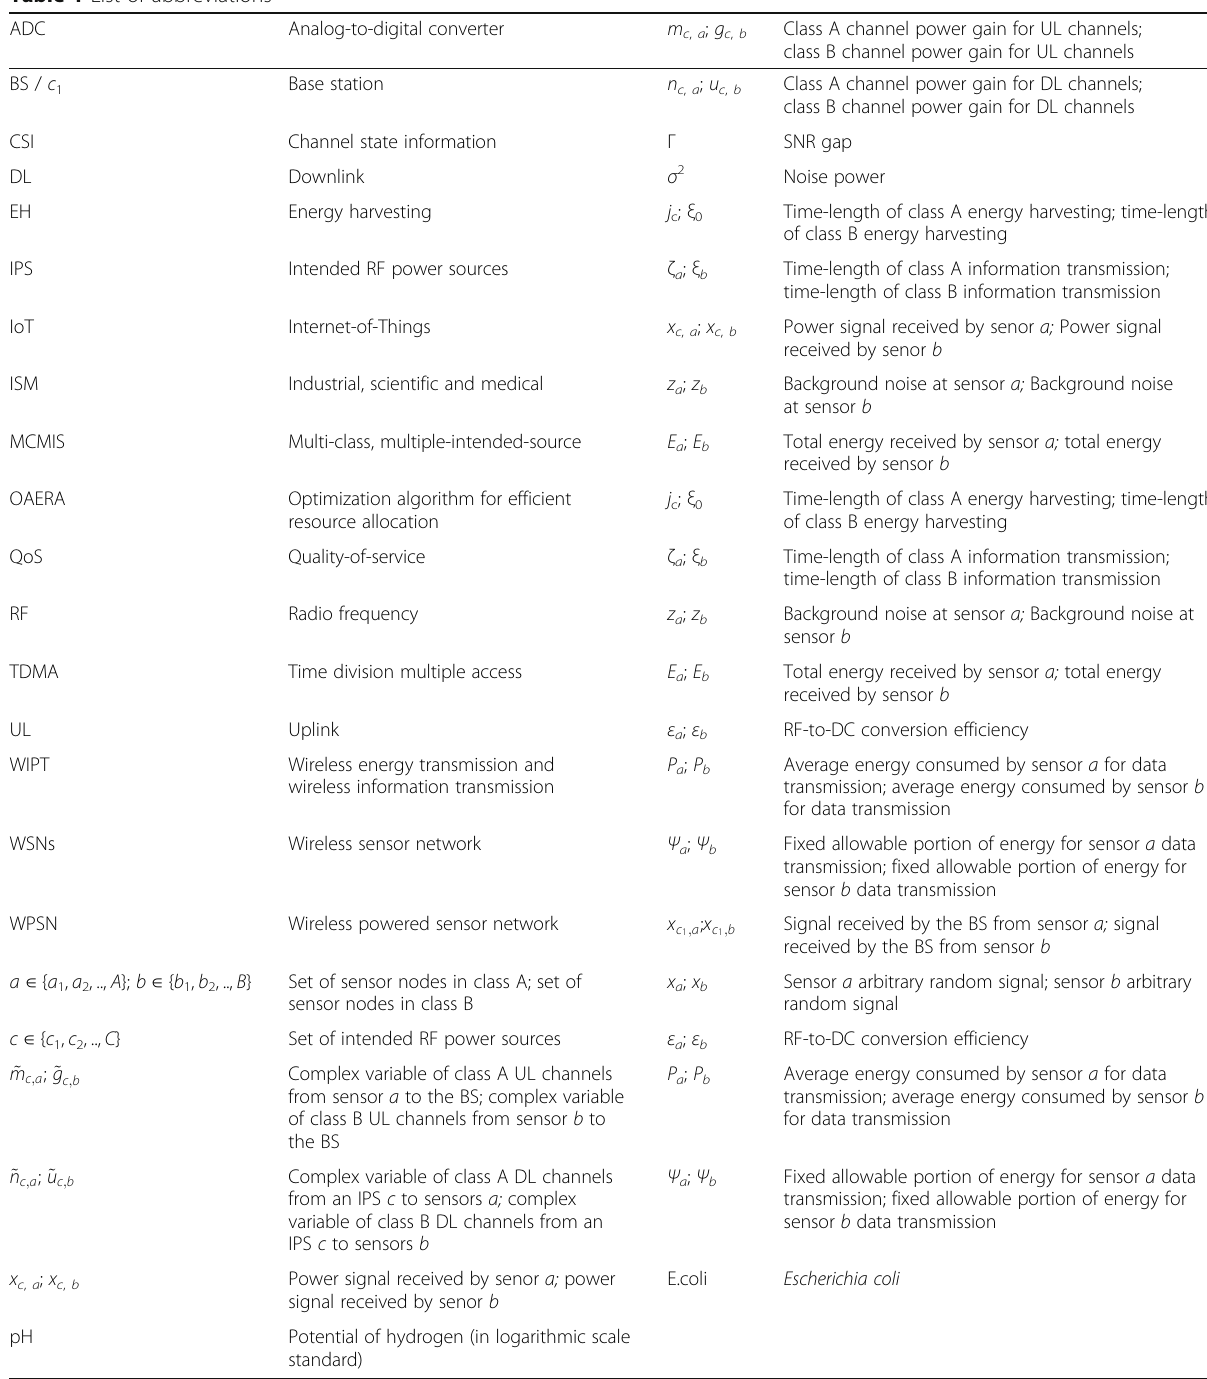
Table 1 List of